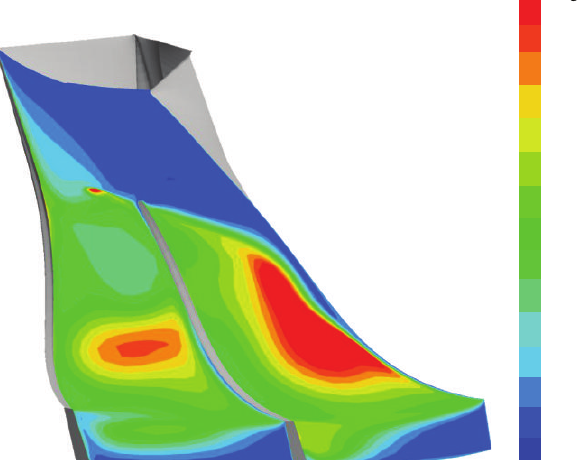
Figure 14: 𝑏/𝑏 2 = 0.91 .